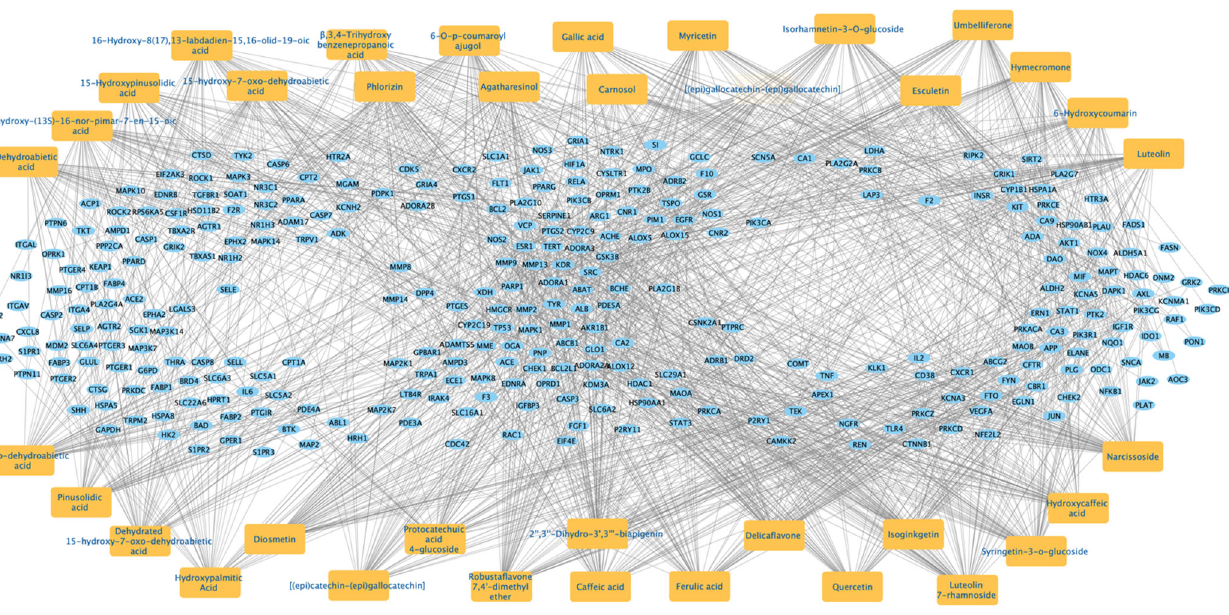
Figure 5. Agathis Robusta bark extract (ARBE) compounds—RIRI targets network. Table 2. Major compounds of ARBE ranked by the Degree method.